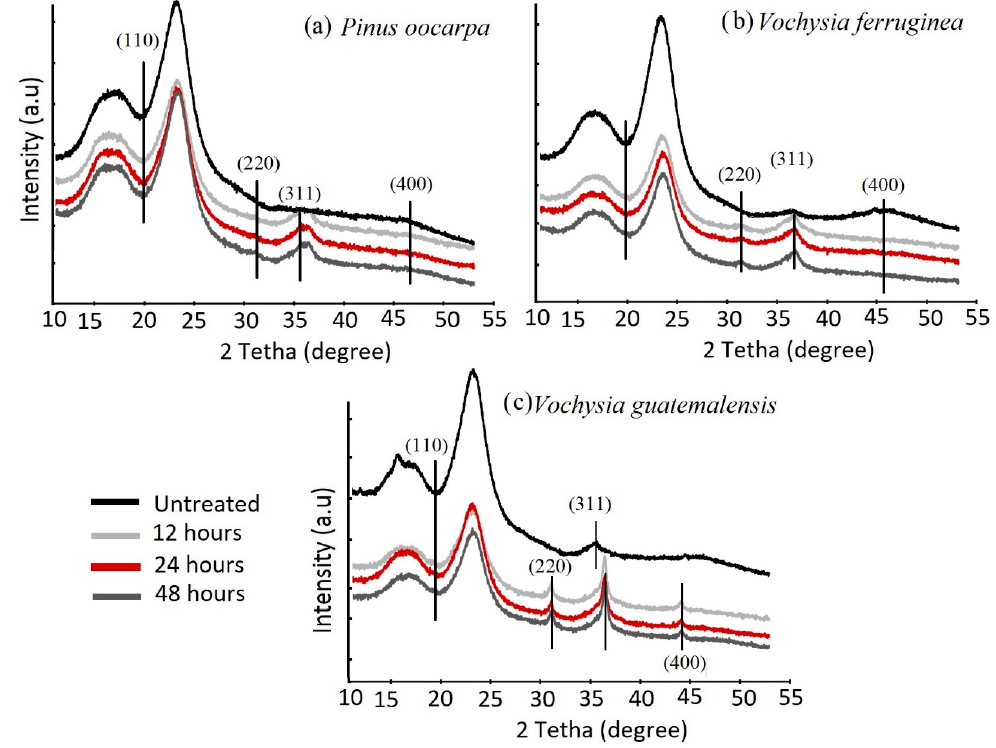
Figure 3. X-ray diffraction ( XRD) in untreated wood and magnetic wood of three tropical wood species from fast-growth plantations in Costa Rica: ( a ) Pinus oocarpa , ( b ) Vochysia ferruginea and ( c ) Vochysia guatemalensis .